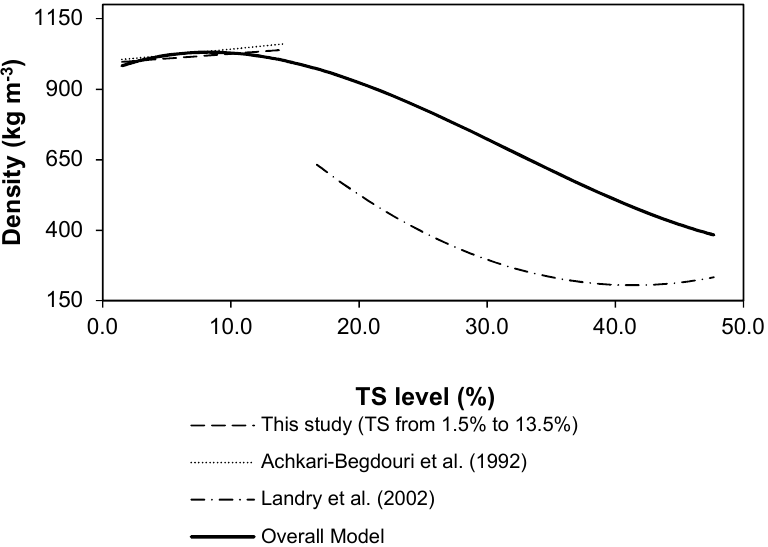
Figure 2. Comparison of three models relating density to TS content for manure only (pre-digestion). The overall model considers samples only from farms A, C–G.